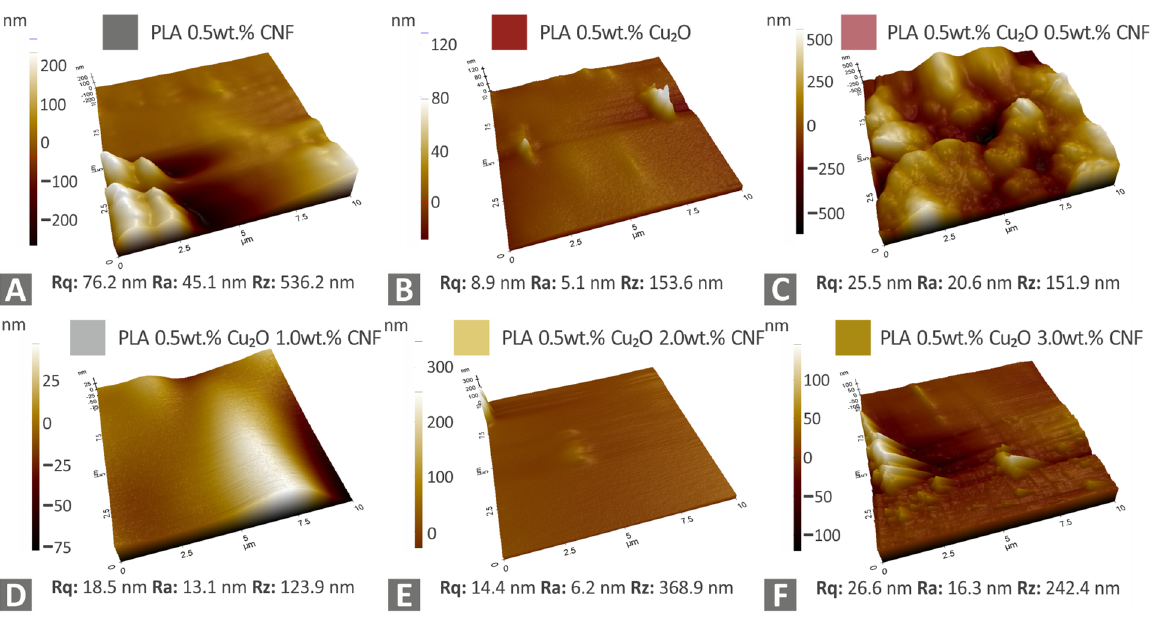
Figure 5. Filament surface morphology of all tested nanomaterials, PLA with: ( A ) 0.5 wt.% CNF, ( B )